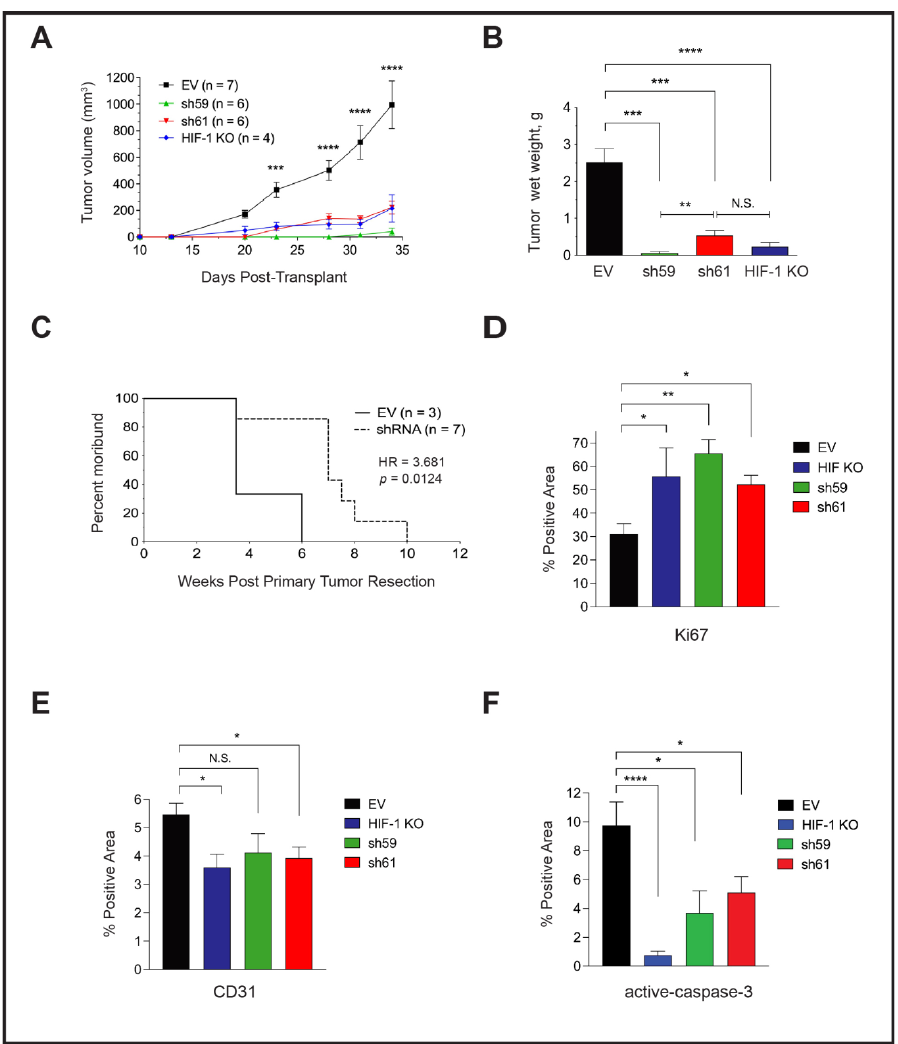
Figure 5. Tumor-cell-intrinsic CKB promotes PyMT primary tumor growth and lung metastasis in vivo, and the deletion of CKB in the tumor epithelium improves overall survival. ( A ) Growth rate over time after transplantation of PyMT EV, HIF-1 KO, sh59 KD, and sh61 KD cells into the inguinal mammary fat pad of female FVB/Nj recipients. Mean tumor volume ± SEM is shown. ( B ) All tumors harvested at day 34 from panel ( A ) were weighed to determine the mean wet weight (g) ± SEM at the experiment endpoint. Data in ( A , B ) are representative of two independent experiments. ( C ) The impact of CKB expression in the PyMT tumor epithelium on the survival of recipients following tumor resection. Mice implanted with PyMT cells (EV or either shRNA KD construct) were subjected to primary tumor resection after tumors grew to similar volumes (~500 mm 3 ), and mice were allowed to survive post-resection until moribund due to lung metastasis. Mice were removed from the study when panting due to lung metastasis, or if bodyweight decreased by >15%. The morbidity hazard ratio (HR) was 3.68-fold higher when FVB/Nj recipients bore Ckb WT tumors ( n = 3 mice for EV and n = 7 total mice for Ckb shRNA knockdown, representing either sh59 KD or sh61 KD tumors). ( D – F ) Immunostaining of PyMT EV ( n = 5 tumors), HIF-1 KO ( n = 4 tumors), sh59 KD ( n = 4 tumors) or sh61 KD ( n = 5 tumors) sections to enumerate Ki67 ( D ), CD31 ( E ) or activated-caspase 3. ( F ) The mean ± SEM of the percentage (%) of the positive area of whole tumor sections is reported for each